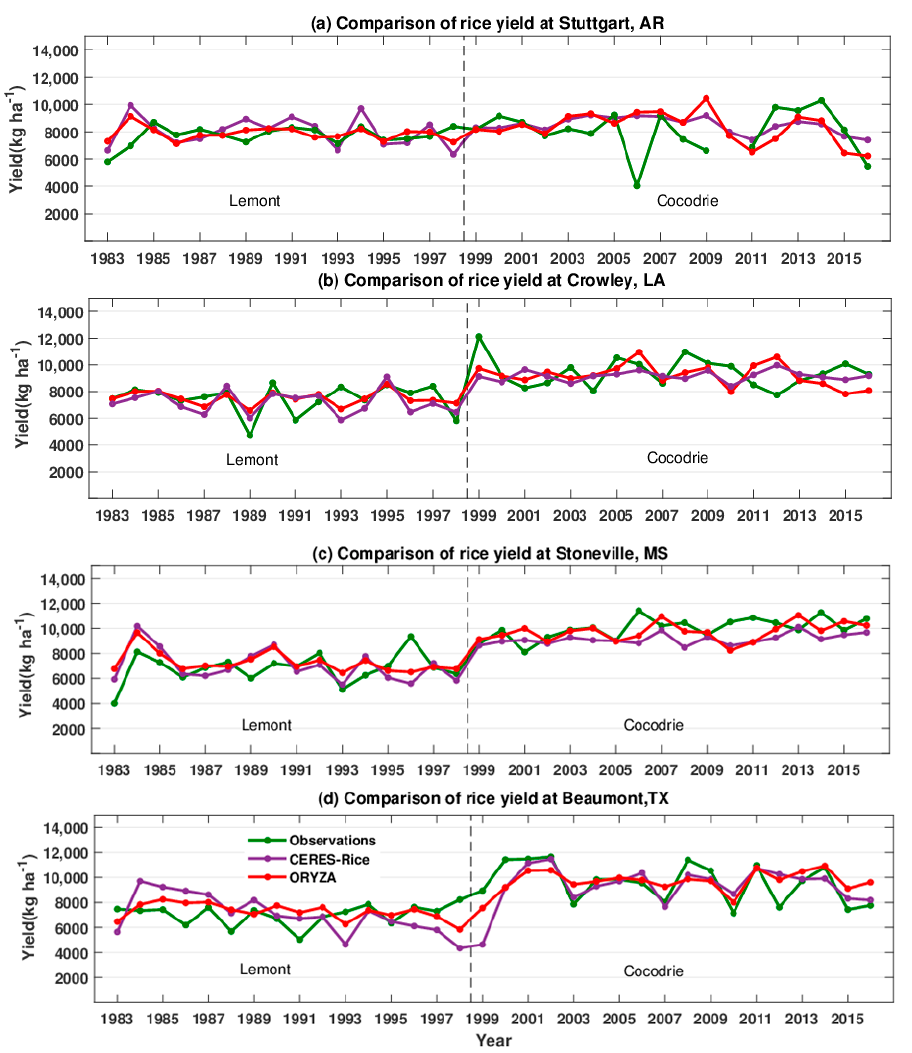
Figure 4. Comparison of observed and simulated rice yield obtained from CERES-Rice and re-parameterized ORYZA for Lemont from 1983 to 1998 and for Cocodrie (CCDR) from 1999 to 2016 at ( a ) Stuttgart, AR, ( b ) Crowley, LA, ( c ) Stoneville, MS, and ( d ) Beaumont, 2016.